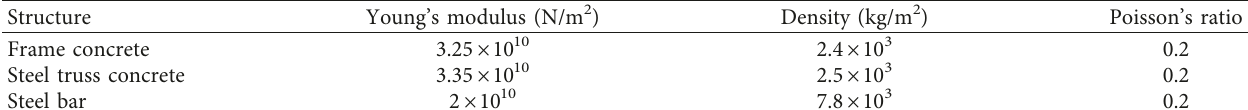
Table 1: Material properties.